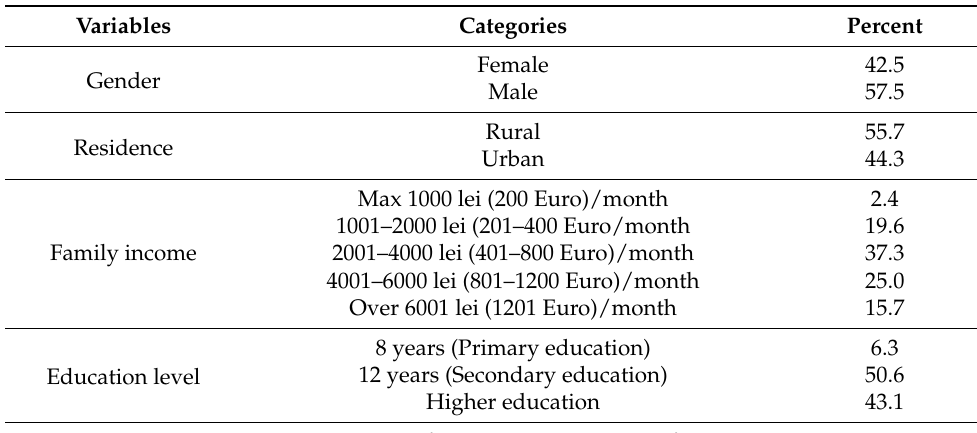
Table 2. Sample characteristics.